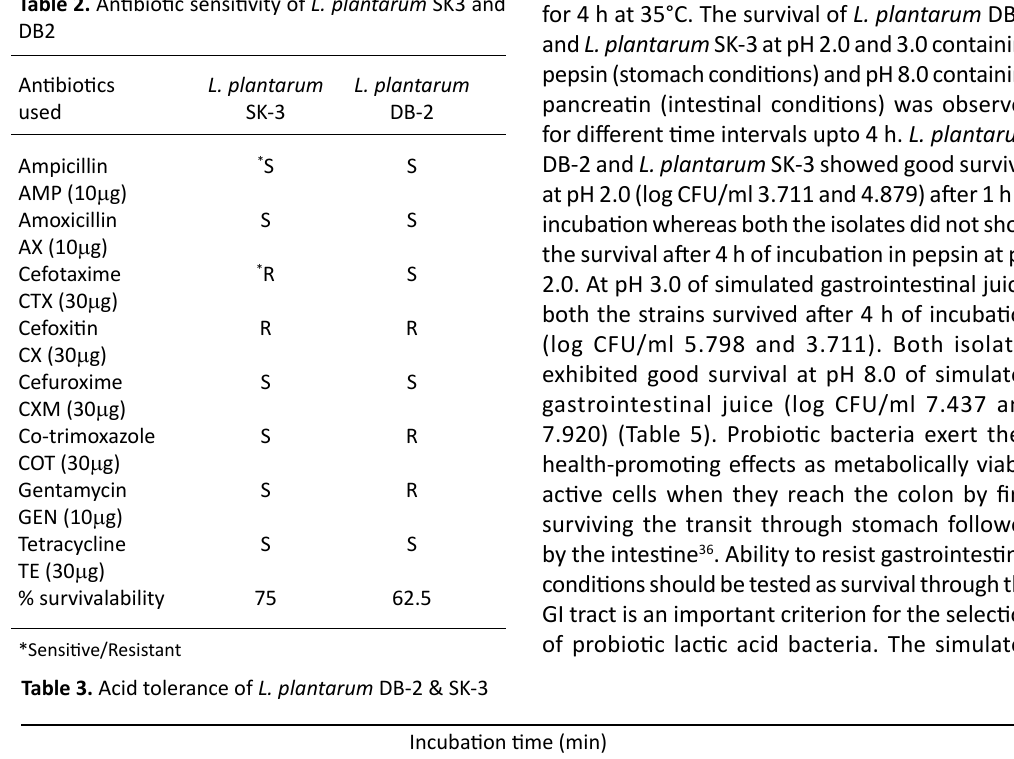
Table 2. Antibiotic sensitivity of L. plantarum SK3 and